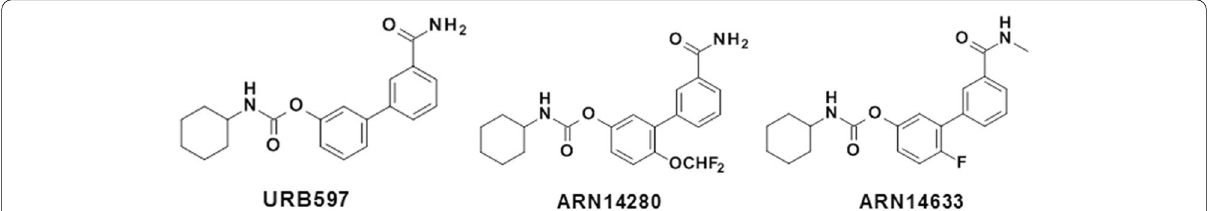
Fig. 1 Chemical structures of URB597, ARN14280 and